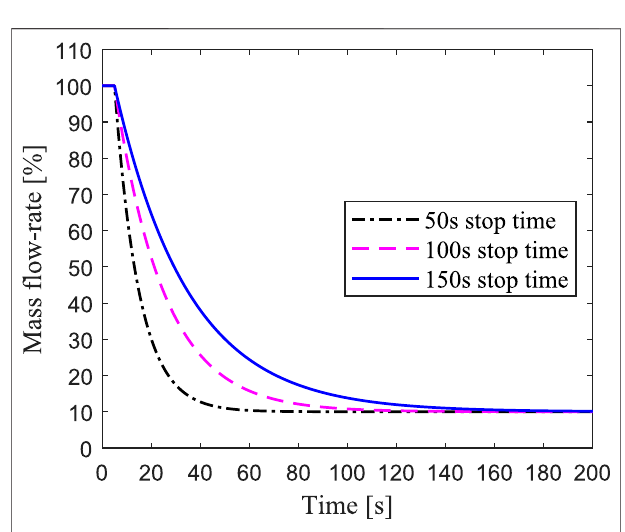
FIGURE 13 | Effect of pump coastdown time on mass fl